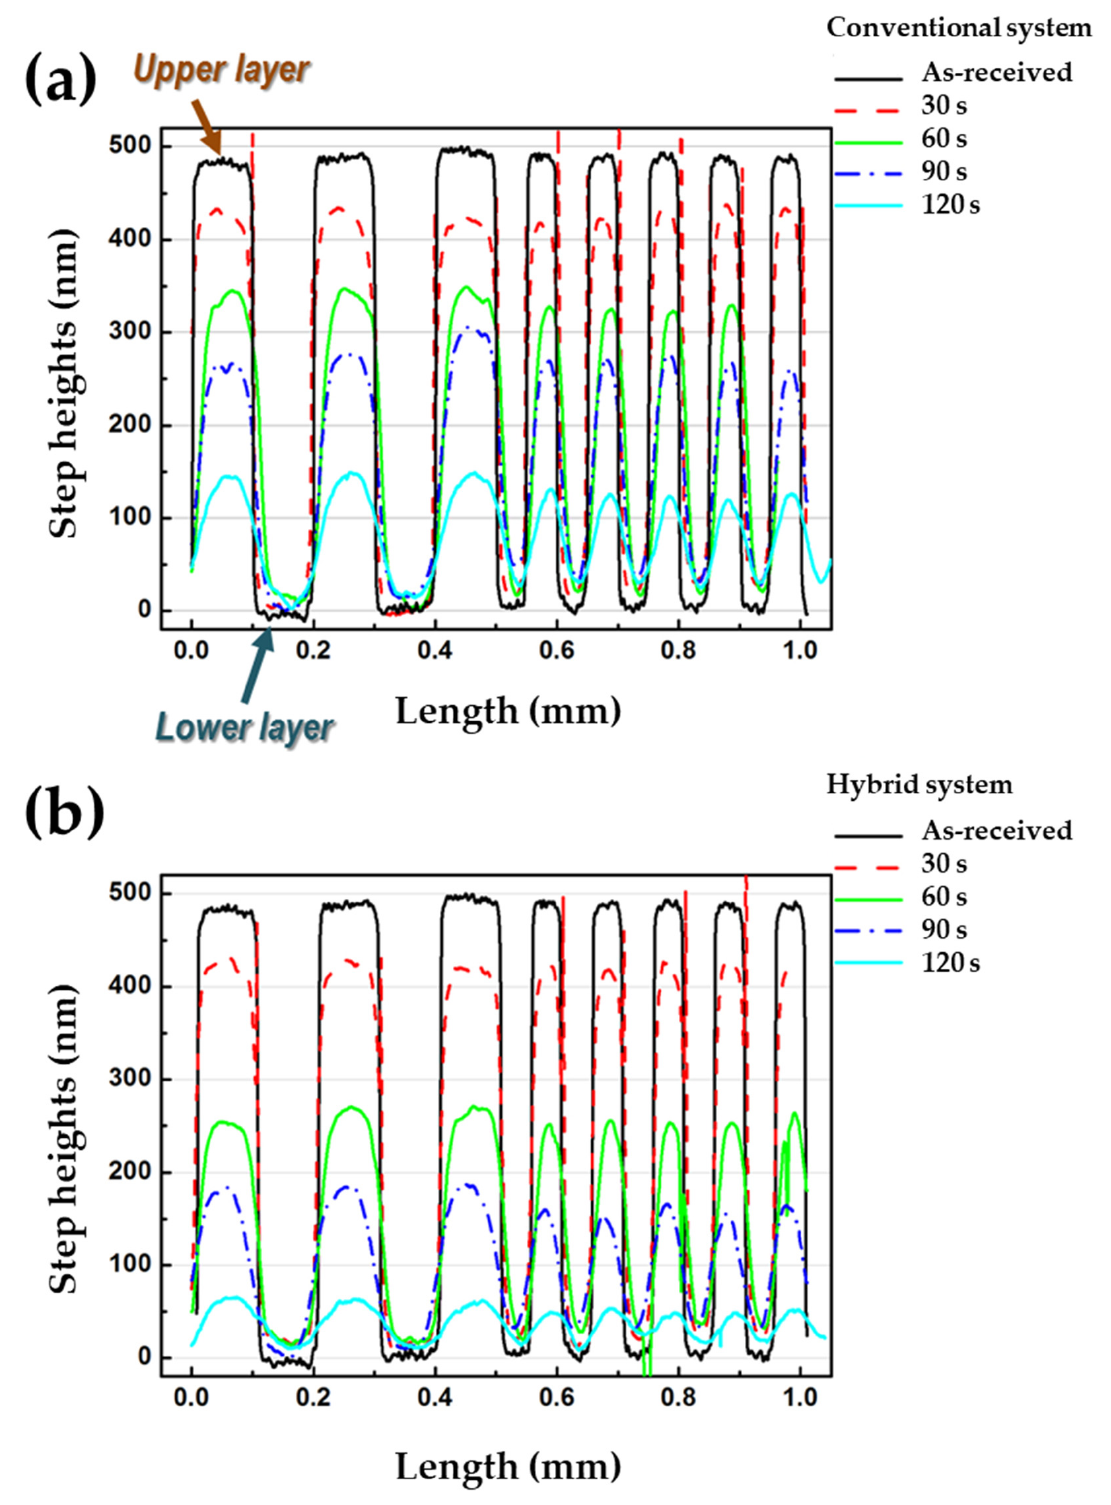
Figure 7. The 2D patterns of the surface profiles at 200- and 100- µ m pitches. ( a ) The conventional system and ( b ) the hybrid system.